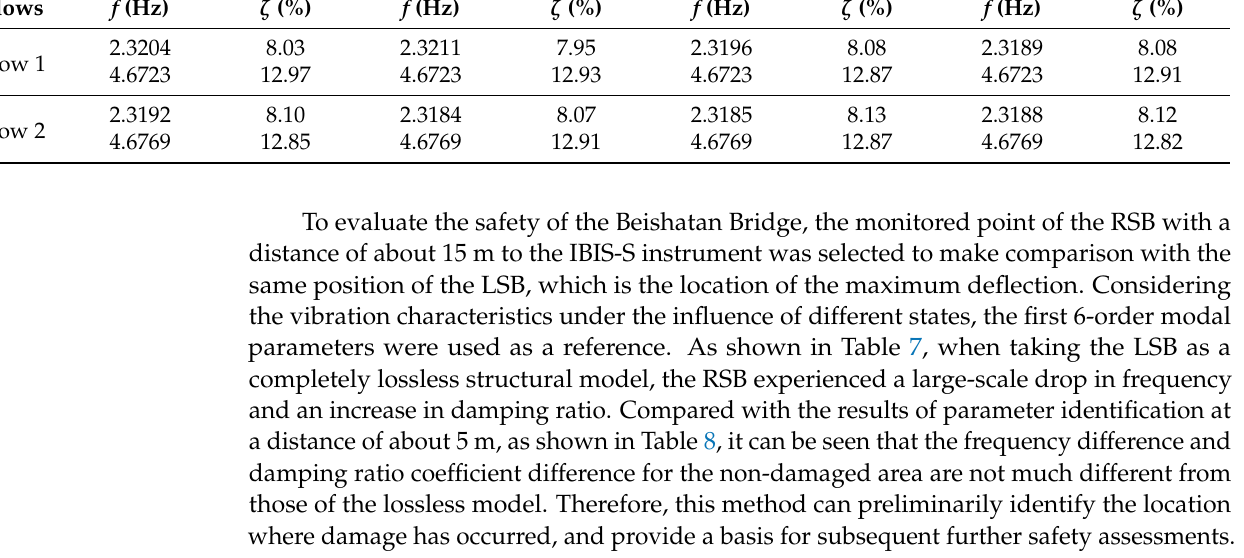
Table 7. Modal parameters identified at distance of about 15